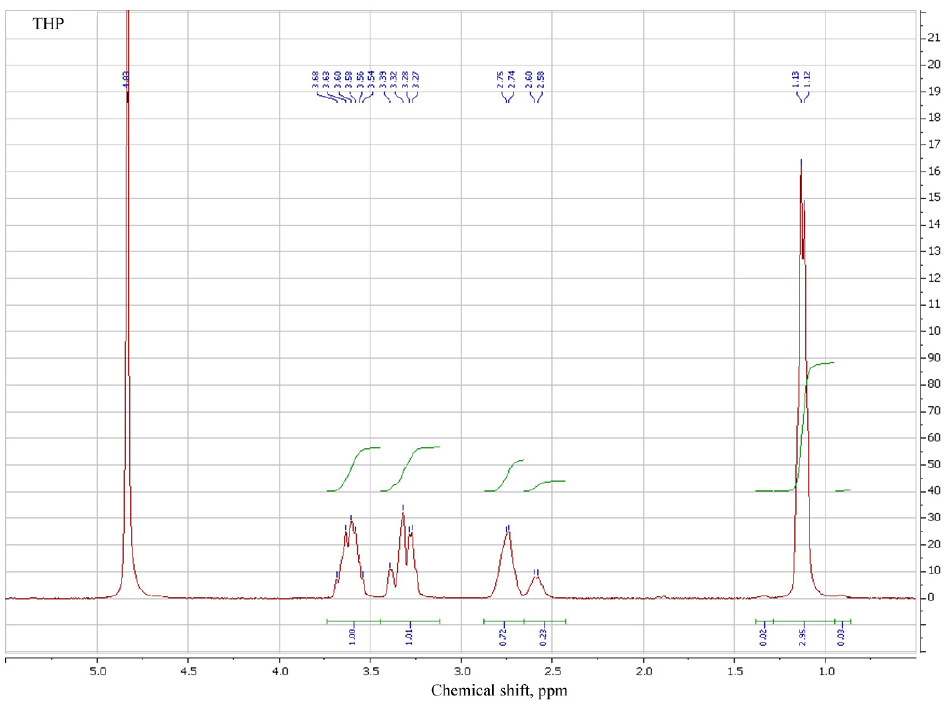
Figure 6. NMR 1 H spectrum of MTHP/DADMAC copolymer in deuterated water (insoluble fraction after dialysis, [M] Σ1 = 1M).